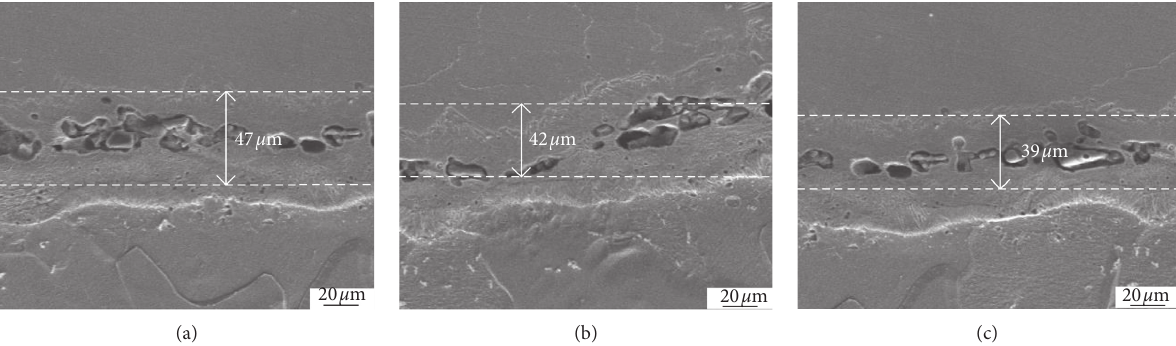
Figure 9: SEM morphology of the bonding layer with 30% reduction rate (500x). (a) Area I. (b) Area II. (c) Area III.